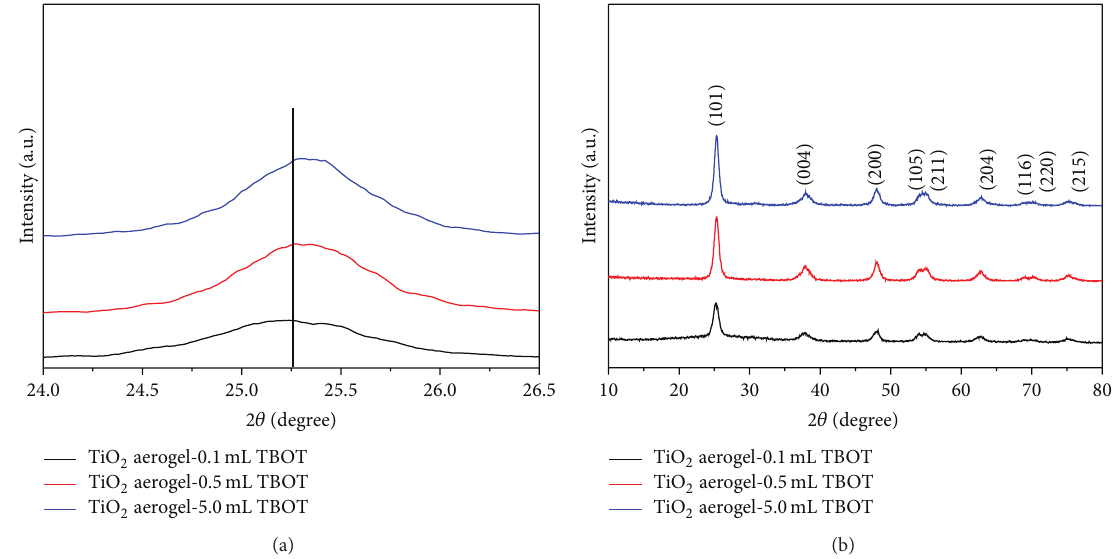
Figure 5: XRD patterns of Ti diffraction peak at 2𝜃 = 25.26 ∘ (a) and TiO 2 aerogels calcinated at 500 ∘ C for 3 h.